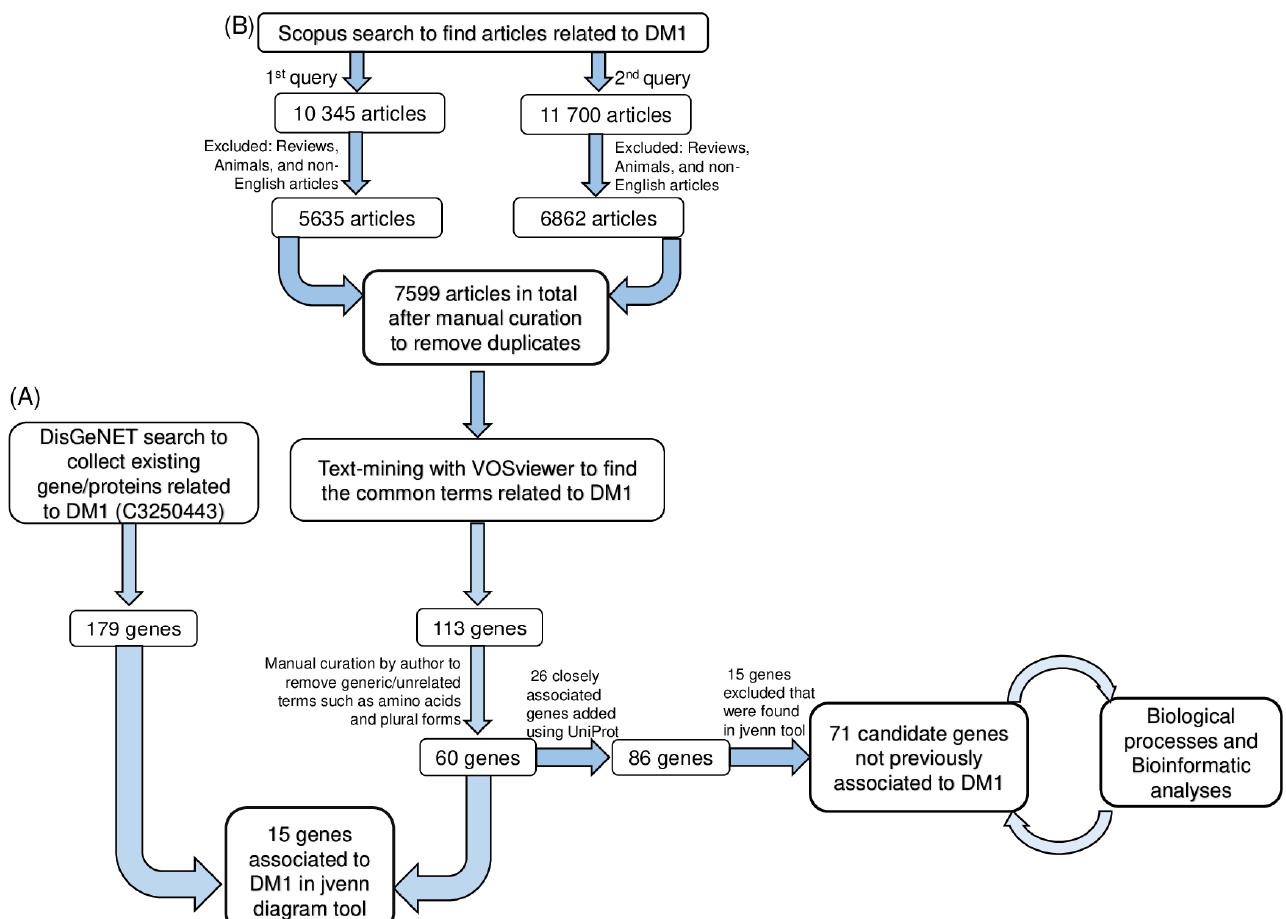
Figure 1. Workflow of the strategy used for literature search and bibliometric analysis to unravel a functional association between myotonic dystrophy type 1 and metabolism. ( A ) DisGeNET ‐ based collection of previously reported molecular associations with DM1. Terminologies corresponding to genes only were selected and compared with DisGeNET data. This analysis yielded a set of 15 genes previously associated with DM1 in DisGeNET. ( B ) Workflow used to obtain the common terms related to metabolism/metabolic and DM1 using VOSviewer software. Following the literature search, text-mining with VOSviewer software was used to uncover the most appropriate terminologies from scientific articles. We also focused on the 71 genes identified in VOSviewer analysis but that were not previously associated with DM1 in DisGeNET. These genes emerged as potential DM1 targets. DM1, myotonic dystrophy type 1.